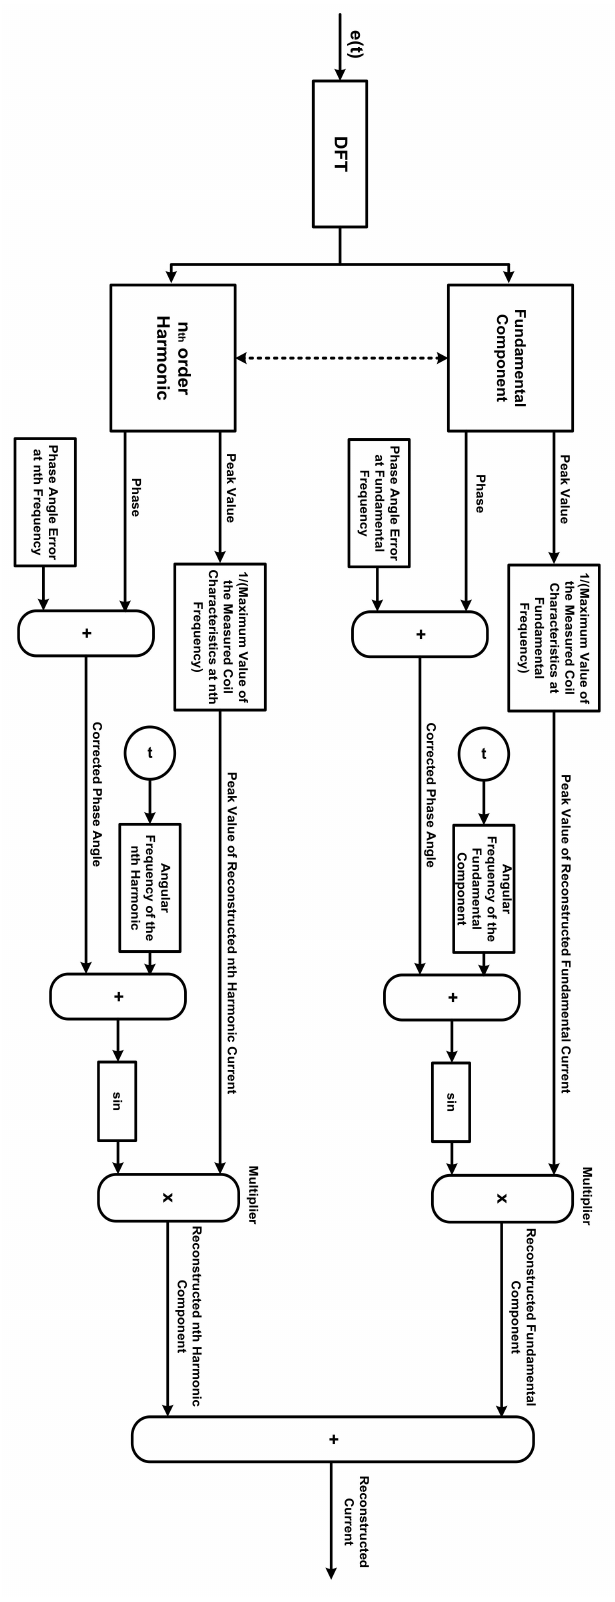
Figure 3. The Adopted Current Reconstruction